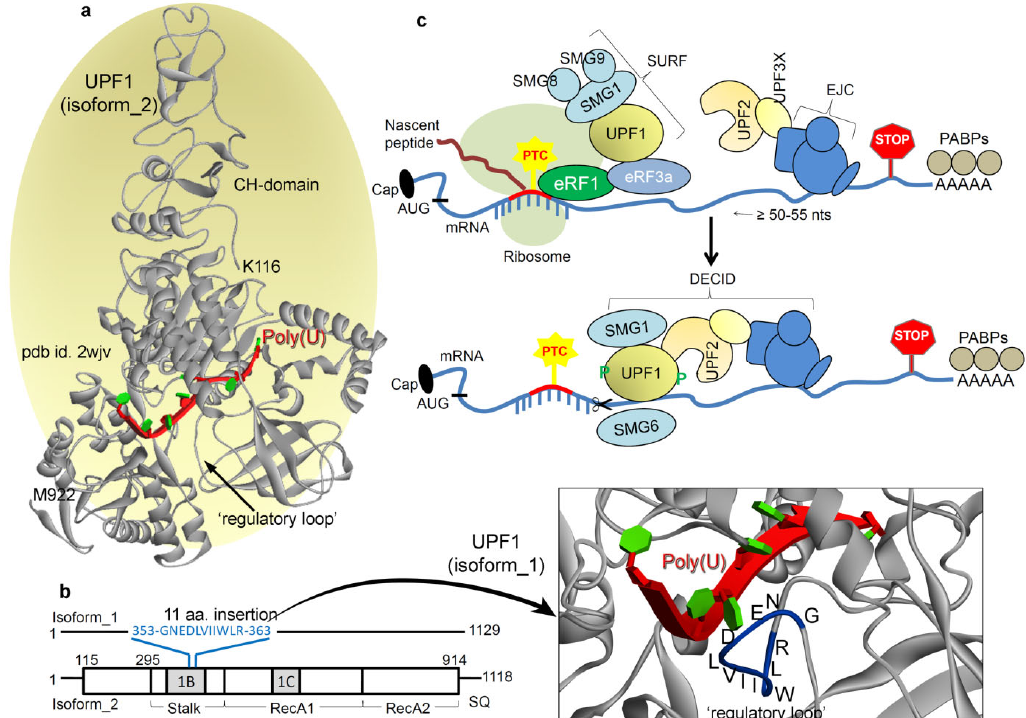
Figure 1. The master regulator of the NMD (nonsense-mediated mRNA decay) pathway: UPF1 (UP-frameshift 1). ( a ) Optimized UPF1 isoform_2 model structure [40] with the poly(U) mRNA motif, constructed based on the pdb (protein data bank) id: 2wjv [67] and 2xzo [37]. The crystal structure of UPF1 (pdb id: 2wjv [67]) is with the UPF2 protein, but since UPF1 adopts a different conformation when bound with UPF2, we removed it from the presentation. In addition, the poly(U) mRNA motif has been inserted into the structural representation (from pdb id: 2xzo [37]) as a reference since it is not present in the original crystal structure (pdb id: 2wjv [67]). ( b ) Isoform_1 structure of the UPF1 (build considering the pdb id: 2wjv [67])